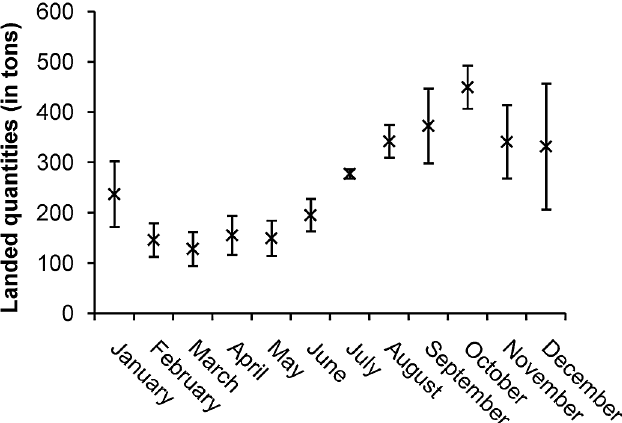
Fig. 3. Variation of the monthly mean mullet landings in Tunisia and its standard deviation for the period 1995 – 2015.